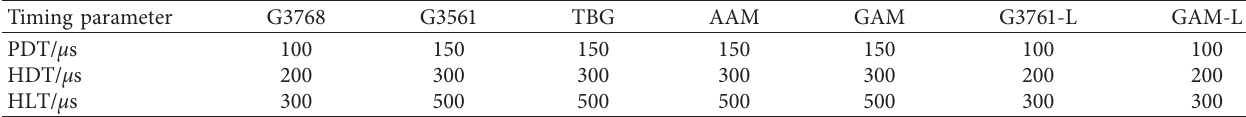
Table 3: Timing parameters in the